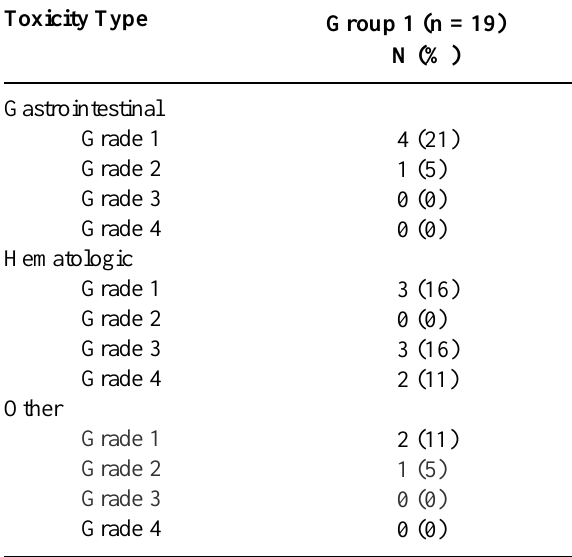
Table 4 – Distribution of chemotherapy toxicity by